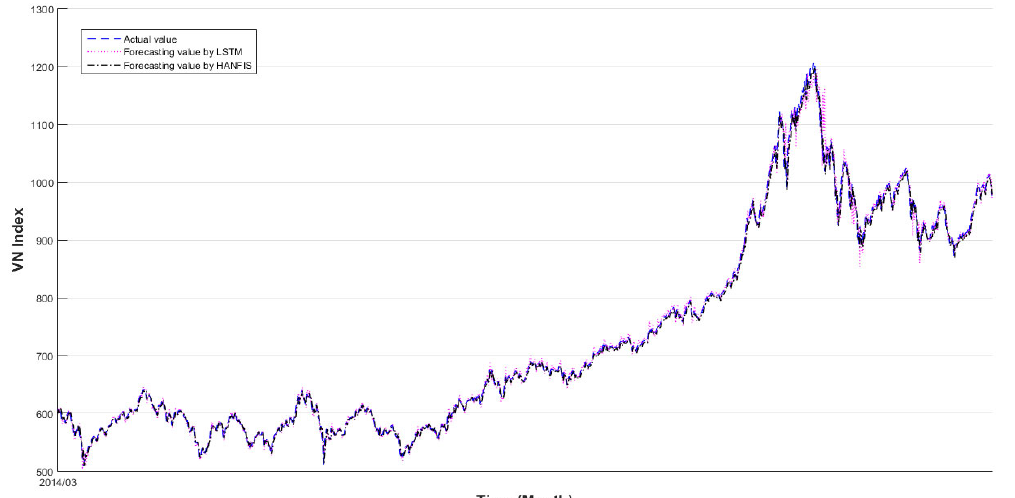
Fig. 14. Comparison between VNIndex predicted by HANFIS and LSTM models and actual The average performance criteria for each model were calculated and are presented in Table 1. The performance criteria RMSE , MAPE , MAE , and R obtained by HANFIS model were calculated as 12.5689 , 0.0102 , 7.9529 , and 0.9976 . Performance indexes calculated by LSTM are 9.9566 , 0.0091 , 7.0809 , and 0.9987 for RMSE , MAPE , MAE , and R , respectively. Theoretically, a forecasting model